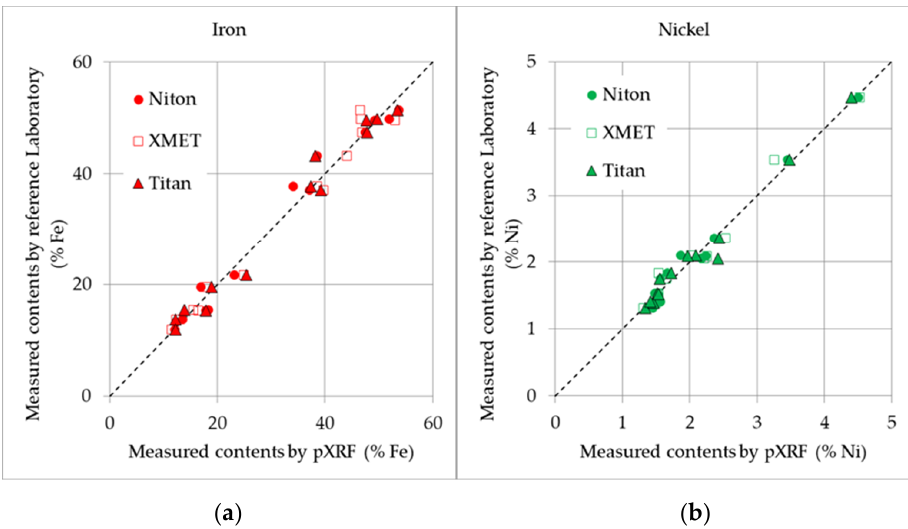
Figure 14. Results of the saturation method after calibration (linear regression): ( a ) Fe oxyde; ( b ) Ni. The Table 7 quantifies the mean error and the root-mean-square error obtained by a linear correction law. Table 7. Parameters of the linear regression between in situ measurements of water-saturated sam- ples and contents measured by reference laboratory for the two elements and for the three devices (a: Slope, b: y-intercept, R²: Coefficient of determination, ME: Mean error, RMSE: Root-mean-square error).